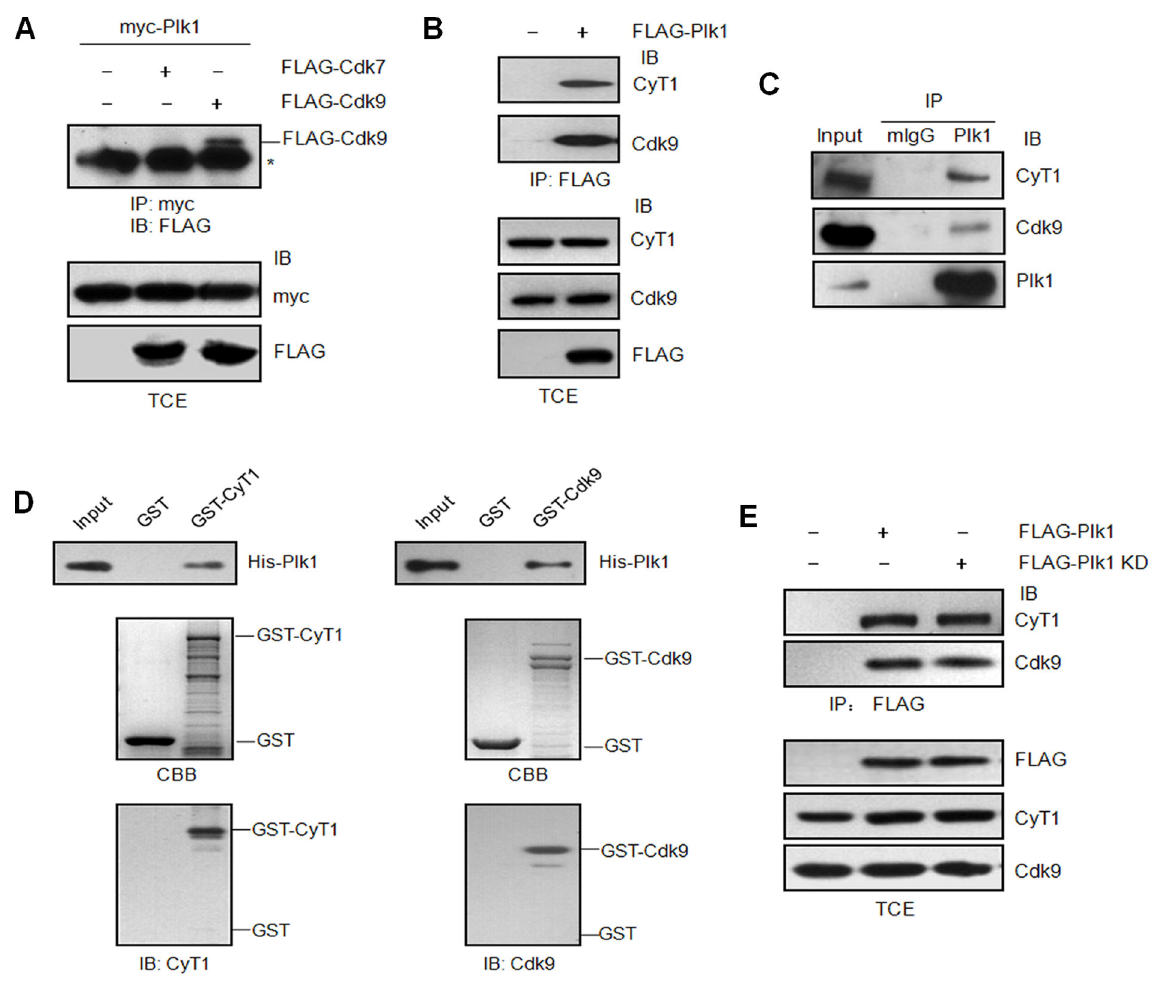
Figure 1. Plk1 interacts with P-TEFb independent of it kinase activity. (A) 293T cells were transfected with pCMV myc-Plk1 and pCMV FLAG-Cdk7 or FLAG-Cdk9, or empty vector as the control. The total cell extracts (TCE) were immunoprecipitated (IP) with myc antibody and immunoblotted (IB) with FLAG antibody. Asterisk indicates cross-reacting unrelated band. (B) 293T cells were transfected with empty vector or pCMV FLAG-Plk1. The total cell extracts were immunoprecipitated with FLAG antibody and immunoblotted with Cdk9 and cyclin T1 antibodies. The empty vector was used as the negative control. (C) HeLa cells were synchronized in M phase by Nocodazole treatment. The cell lysates were harvested and immunoprecipitated with normal mouse serum or Plk1 antibody, and then immunoblotted with Cdk9, cyclin T1 and Plk1 antibodies respectively. (D) GST pull-down assay. Purified His-Plk1 was incubated with immobilized GST, GST-cyclin T1 or GST-Cdk9 respectively. The bound protein was detected by immunoblotting with Plk1 antibody. CBB , Coomassie Brilliant Blue. (E) 293T cells were transfected with pCMV FLAG-Plk1, pCMV FLAG-Plk1 KD (K82R) or empty vector as the control. The cell lysates were immunoprecipitated with FLAG antibody and immunoblotted with Cdk9 and cyclin T1